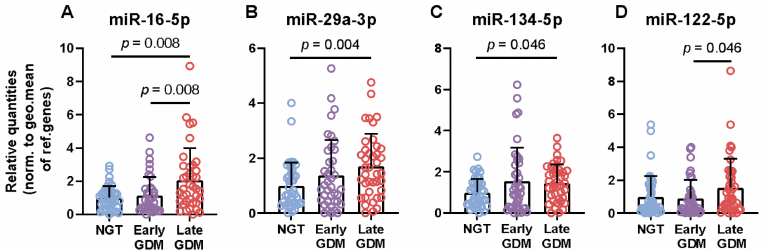
Figure 1. Circulating miRNAs are elevated in late GDM cases. Relative mean quantities with standard deviations of serum microRNAs expressed in the three groups ( A – D ). Data were normalized against the geometric mean of snRNA U6, ath-miR-159 and c.el.miR-39. All indicated p -values were determined by independent t-test on logarithmic transformed data with Bonferroni correction for multiple comparisons. Table 2. Significant Pearsons correlations between clinical variables and circulating miRNAs.